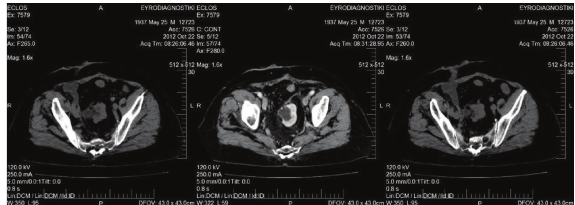
Figure1:PreoperativeCTofcase 1:bladdercarcinomapreoperative and left pelvic kidney.